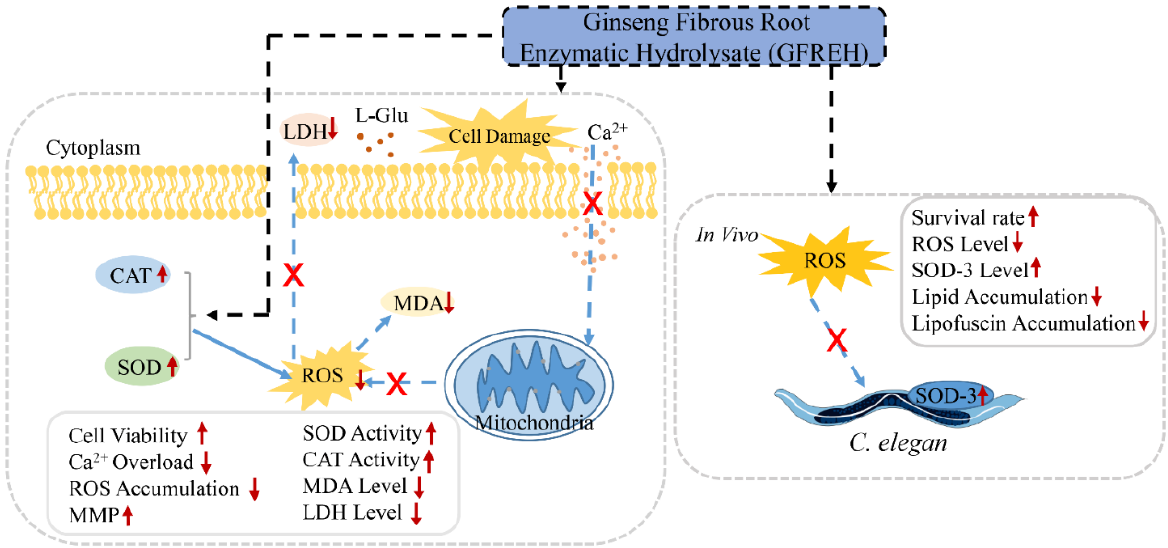
Figure 1. Schematic experiments of GFREH’s effect on oxidative stress and neurotoxicity. In cell assays, AD model was established by treating L-Glu. GFREH administration increased cell viability, which may be achieved by reversing intracellular Ca 2+ influx, maintaining MMP stability, and up- regulating the expression of antioxidant enzymes to eliminate intracellular ROS. In vivo, GFREH treatment increased nematodes ’ survival rate under OS conditions, upregulated the expression of SOD-3, and decreased intracellular ROS in nematodes exposed to juglone. GFREH treatment also reduced lipid and lipofuscin accumulation. (GFREH: ginseng fibrous root enzymatic hydrolysate; OS: oxidative stress; L-Glu: L-glutamic acid; ROS: reactive oxygen species; MMP: mitochondrial membrane potential; SOD: superoxide dismutase; CAT: catalase; LDH: lactate dehydrogenase; MDA: Malondialdehyde). 2. Results 2.1. GFREH Effectively Scavenged Free Radicals In Vitro We evaluated the free radical-scavenging ability of GFREH using vitamin C (VC) as a positive control to explore its antioxidant activity in vitro. As shown in Figure 2A, GFREH increased 2 ’ -azino-bis (3-ethylbenzothiazoline-6-sulfonic acid) (ABTS) free radi- cal-scavenging activity in a concentration-dependent manner, and the scavenging ratio was the same as that of VC, reaching 100% at a concentration of 0.5 mg/mL. Likewise, GFREH improved 2-diphenyl-1-picrylhydrazyl (DPPH) free radical-scavenging activity (Figure 2B), and the scavenging rate was 69.55%. Figure 2C showed the ability of GFREH to eliminate hydroxyl radicals. The results showed that both VC and GFREH increased the scavenging rates of hydroxyl radicals. The concentration of both was 1 mg/mL, and the scavenging rates reached 68.7% and 64.1%, respectively. In Figure 2D, the scavenging rate of GFREH for superoxide anions was 58.41%.